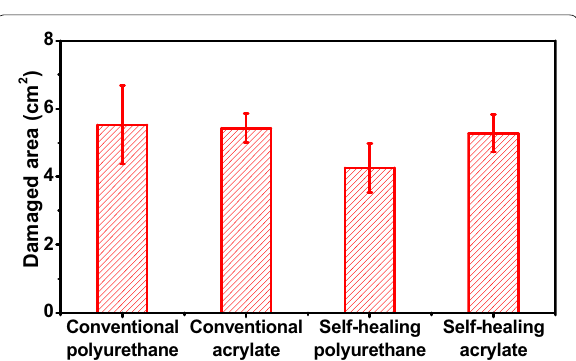
Conventional Conventional polyurethane acrylate Fig. 7 Thickness of coatings. Error bars represent the standard deviation